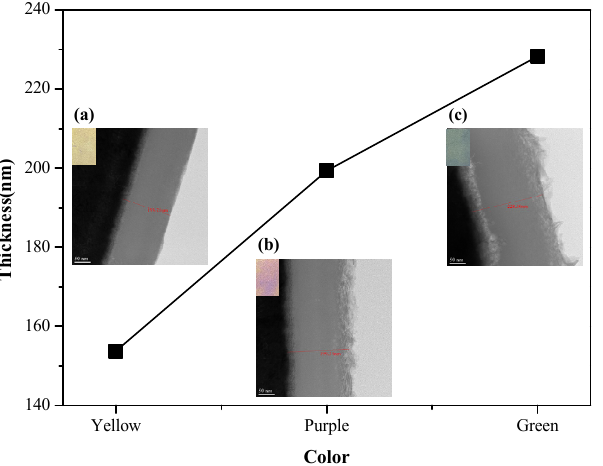
Figure 10. Graph illustrating changes in the film thickness with the exterior color of Zn–Ni alloy plating with colored chromate, subjected to chromium conversion treatment for ( a ) 30 s, ( b ) 60 s, and ( c ) 120 s.